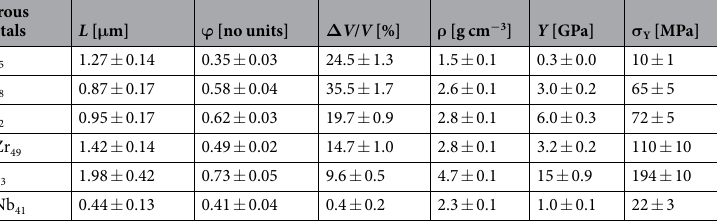
Table 1. Structural parameters and mechanical properties of the porous metals (without polymer phase). L – ligament size, ϕ – solid volume fraction, Δ V/V – relative volume shrinkage during dealloying, ρ - mass density, Y – Young’s modulus, σ Y – yield strength.